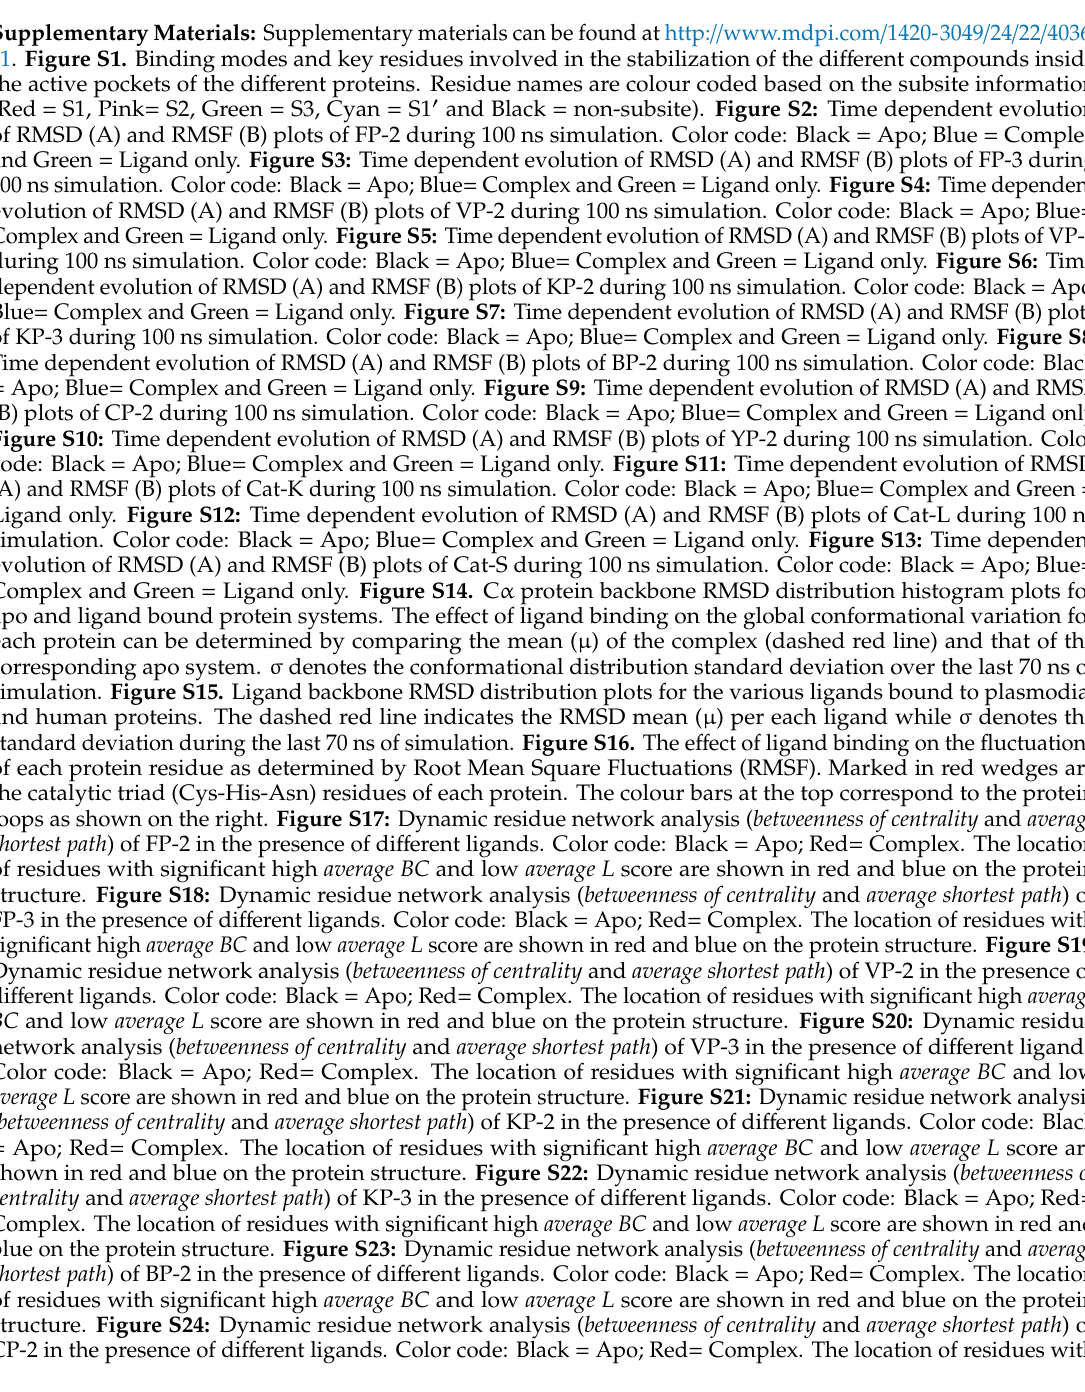
s1. Figure S1. Binding modes and key residues involved in the stabilization of the di ff erent compounds inside the active pockets of the di ff erent proteins. Residue names are colour coded based on the subsite information (Red = S1, Pink = S2, Green = S3, Cyan = S1 (cid:48) and Black = non-subsite). Figure S2: Time dependent evolution of RMSD (A) and RMSF (B) plots of FP-2 during 100 ns simulation. Color code: Black = Apo; Blue = Complex and Green = Ligand only. Figure S3: Time dependent evolution of RMSD (A) and RMSF (B) plots of FP-3 during 100 ns simulation. Color code: Black = Apo; Blue = Complex and Green = Ligand only. Figure S4: Time dependent evolution of RMSD (A) and RMSF (B) plots of VP-2 during 100 ns simulation. Color code: Black = Apo; Blue = Complex and Green = Ligand only. Figure S5: Time dependent evolution of RMSD (A) and RMSF (B) plots of VP-3 during 100 ns simulation. Color code: Black = Apo; Blue = Complex and Green = Ligand only. Figure S6: Time dependent evolution of RMSD (A) and RMSF (B) plots of KP-2 during 100 ns simulation. Color code: Black = Apo; Blue = Complex and Green = Ligand only. Figure S7: Time dependent evolution of RMSD (A) and RMSF (B) plots of KP-3 during 100 ns simulation. Color code: Black = Apo; Blue = Complex and Green = Ligand only. Figure S8: Time dependent evolution of RMSD (A) and RMSF (B) plots of BP-2 during 100 ns simulation. Color code: Black = Apo; Blue = Complex and Green = Ligand only. Figure S9: Time dependent evolution of RMSD (A) and RMSF (B) plots of CP-2 during 100 ns simulation. Color code: Black = Apo; Blue = Complex and Green = Ligand only. Figure S10: Time dependent evolution of RMSD (A) and RMSF (B) plots of YP-2 during 100 ns simulation. Color code: Black = Apo; Blue = Complex and Green = Ligand only. Figure S11: Time dependent evolution of RMSD (A) and RMSF (B) plots of Cat-K during 100 ns simulation. Color code: Black = Apo; Blue = Complex and Green = Ligand only. Figure S12: Time dependent evolution of RMSD (A) and RMSF (B) plots of Cat-L during 100 ns simulation. Color code: Black = Apo; Blue = Complex and Green = Ligand only. Figure S13: Time dependent evolution of RMSD (A) and RMSF (B) plots of Cat-S during 100 ns simulation. Color code: Black = Apo; Blue = Complex and Green = Ligand only. Figure S14. C α protein backbone RMSD distribution histogram plots for apo and ligand bound protein systems. The e ff ect of ligand binding on the global conformational variation for each protein can be determined by comparing the mean ( µ ) of the complex (dashed red line) and that of the corresponding apo system. σ denotes the conformational distribution standard deviation over the last 70 ns of simulation. Figure S15. Ligand backbone RMSD distribution plots for the various ligands bound to plasmodial and human proteins. The dashed red line indicates the RMSD mean ( µ ) per each ligand while σ denotes the standard deviation during the last 70 ns of simulation. Figure S16. The e ff ect of ligand binding on the fluctuations of each protein residue as determined by Root Mean Square Fluctuations (RMSF). Marked in red wedges are the catalytic triad (Cys-His-Asn) residues of each protein. The colour bars at the top correspond to the protein loops as shown on the right. Figure S17: Dynamic residue network analysis ( betweenness of centrality and average shortest path ) of FP-2 in the presence of di ff erent ligands. Color code: Black = Apo; Red = Complex. The location of residues with significant high average BC and low average L score are shown in red and blue on the protein structure. Figure S18: Dynamic residue network analysis ( betweenness of centrality and average shortest path ) of FP-3 in the presence of di ff erent ligands. Color code: Black = Apo; Red = Complex. The location of residues with significant high average BC and low average L score are shown in red and blue on the protein structure. Figure S19: Dynamic residue network analysis ( betweenness of centrality and average shortest path ) of VP-2 in the presence of di ff erent ligands. Color code: Black = Apo; Red = Complex. The location of residues with significant high average BC and low average L score are shown in red and blue on the protein structure. Figure S20: Dynamic residue network analysis ( betweenness of centrality and average shortest path ) of VP-3 in the presence of di ff erent ligands. Color code: Black = Apo; Red = Complex. The location of residues with significant high average BC and low average L score are shown in red and blue on the protein structure. Figure S21: Dynamic residue network analysis ( betweenness of centrality and average shortest path ) of KP-2 in the presence of di ff erent ligands. Color code: Black = Apo; Red = Complex. The location of residues with significant high average BC and low average L score are shown in red and blue on the protein structure. Figure S22: Dynamic residue network analysis ( betweenness of centrality and average shortest path ) of KP-3 in the presence of di ff erent ligands. Color code: Black = Apo; Red = Complex. The location of residues with significant high average BC and low average L score are shown in red and blue on the protein structure. Figure S23: Dynamic residue network analysis ( betweenness of centrality and average shortest path ) of BP-2 in the presence of di ff erent ligands. Color code: Black = Apo; Red = Complex. The location of residues with significant high average BC and low average L score are shown in red and blue on the protein structure. Figure S24: Dynamic residue network analysis ( betweenness of centrality and average shortest path ) of CP-2 in the presence of di ff erent ligands. Color code: Black = Apo; Red = Complex. The location of residues